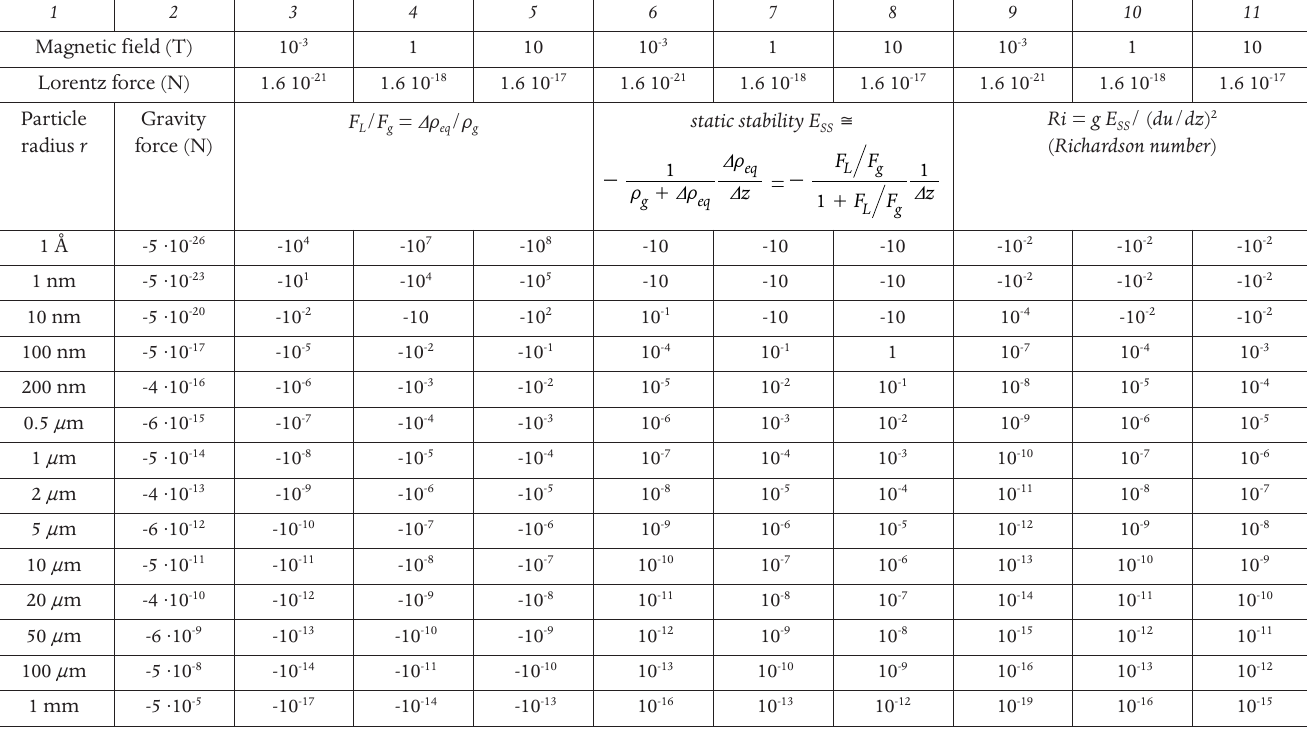
Table 3. Column numbers: column 1, grain radius; column 2, gravity force acting on a particle of a given radius and density t = 1.2 ×10 3 kg/m 3 . Particles g have a reference elementary charge q = -1.6 ×10 -19 C. They move down-slope, integral with the stiffnite, at a velocity of 10 m/s. The magnetic field B dip and the correspondent Lorentz force F acting on a grain are reported in rows 2 and 3, for each column; columns 3, 4, 5, ratios between the magnetic force L F and the gravity force of column 2. Values of columns 3, 4, 5 times t give the equivalent variation = D t in the density of a grain; columns 6, 7, 8, static L g eq stability E for a stiffnite, evaluated by assuming a typical value of D z = 10 -1 m; columns 9, 10, 11, Richardson number Ri , which measures dynamic SS stability in the presence of shear (here = 100 s -1